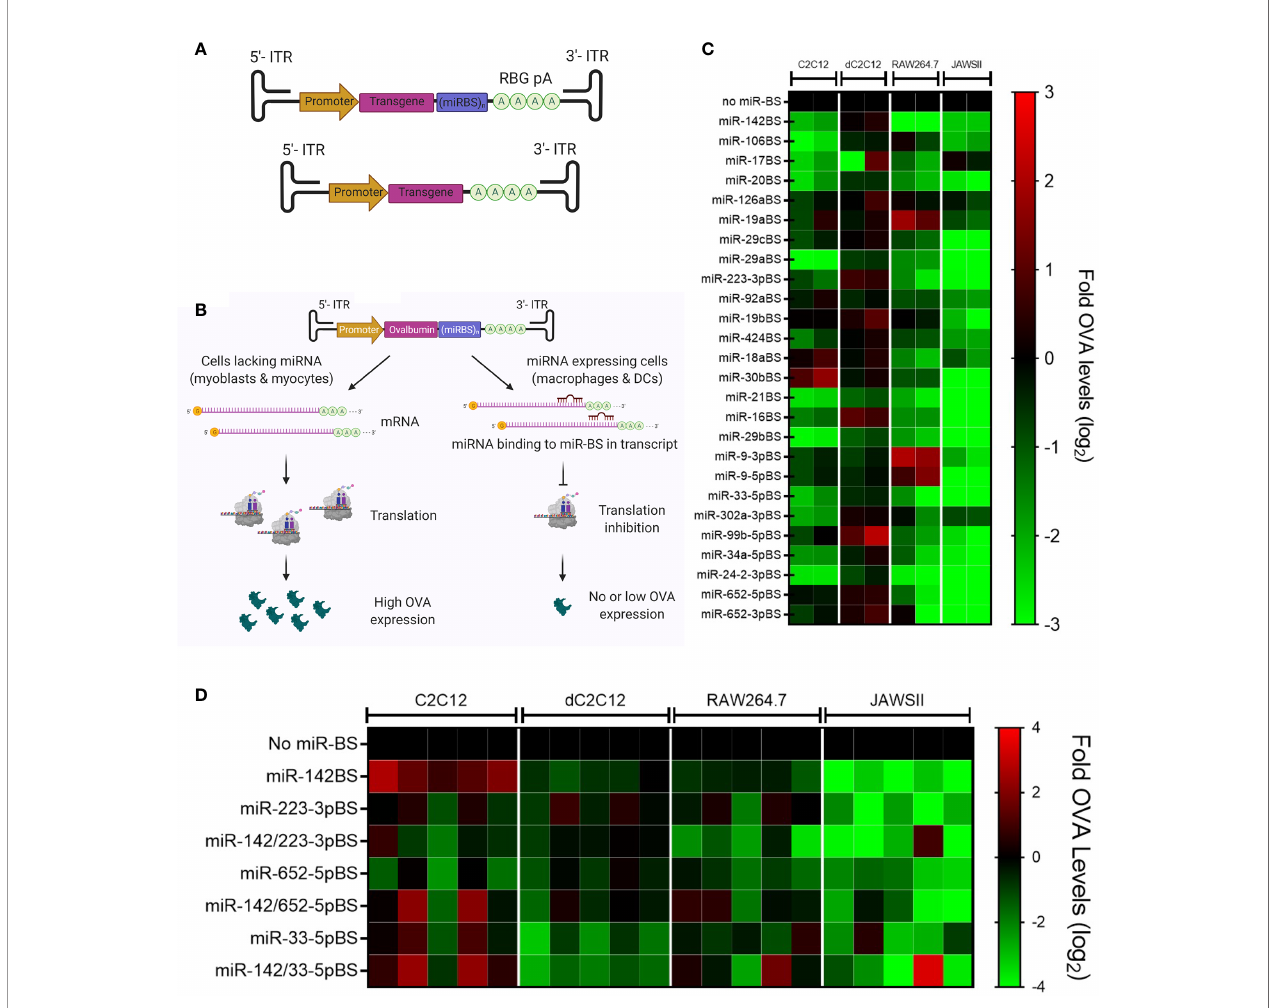
FIGURE 1 | Selection and in vitro screening of candidate miRNA binding sites (miR-BS). (A) Schematic illustration of rAAV. OVA expression vectors. The expression of the OVA transgene is driven by the CB6 promoter. Two copies of miR-BSs are cloned between the transgene and the rabbit b -globin poly A (RBG pA). The OVA expression cassette is fl anked by inverted terminal repeats (ITRs) at both ends. (B) An ideal miR-BS candidate, upon delivery to myocytes and myoblasts, which do not express the corresponding miRNA, is expected to undergo transcription and translation to produce high levels of transgene. In contrast, when this vector is delivered to miRNA-expressing immune cells, like macrophages and DCs, miRNA binding to the transgene mRNA leads to translational inhibition and transcript degradation, resulting in minimal transgene protein production. (C) Summary of the in vitro screening of individual miR-BS candidates represented as a heat map with OVA expression denoted as fold change (log 2 ) with respect to expression vectors lacking any miR-BS. (D) The in vitro screening of miR-BS combinations summarized as a heat map with relative OVA levels represented as fold change (log 2 ) ( n = 5). C2C12, mouse myoblasts; dC2C12, mouse myocytes; RAW264.7, mouse macrophages; JAWSII, mouse ( Figure 2A ). Expression of miR-652-5p in RAW264.7 and JAWSII cells was about 2- and 8-fold higher than levels observed in C2C12 cells, respectively. On the other hand, no signi fi cant enrichment of miR-652-3p and miR-33-5p was seen in immune cell types ( Figure 2A ). We next aimed to assess the function of miR-223-3p and miR- 652-5p binding sites in vivo . We therefore packaged the rAAV- OVA expression cassettes into AAV1 capsids with or without the individual miR-223-3p or miR-652-5p binding sites, or in combination with miR-142BS elements. Produced vectors were then injected into TA muscles of adult mice. Mice administered with rAAV1 empty capsids or PBS (mock) were used as controls.